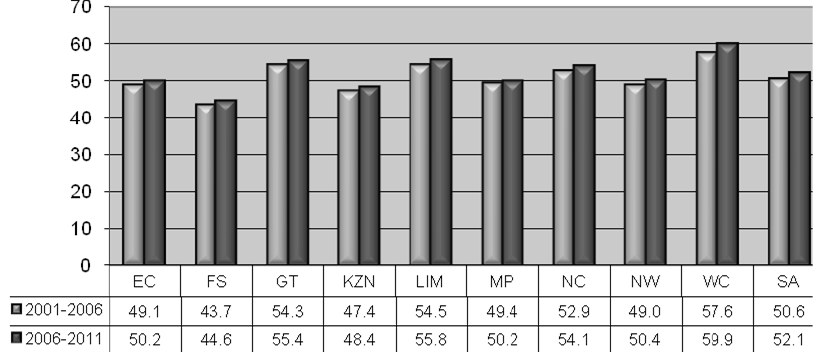
FIGURE 2: Life expectancy per province (male) Source: Statistics South Africa (2011a)